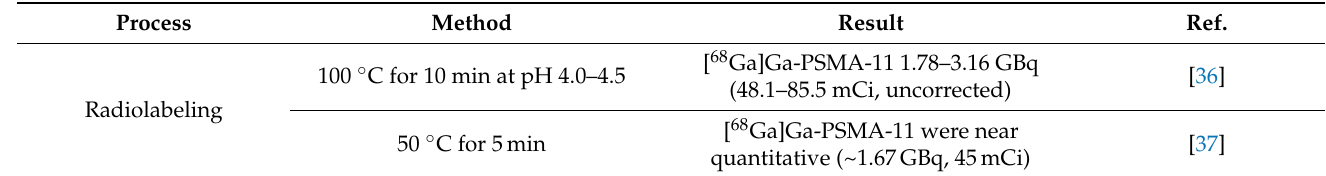
Table 8. Method for [ 68 Ga]Ga-PSMA-11 radiolabelling and the EOS